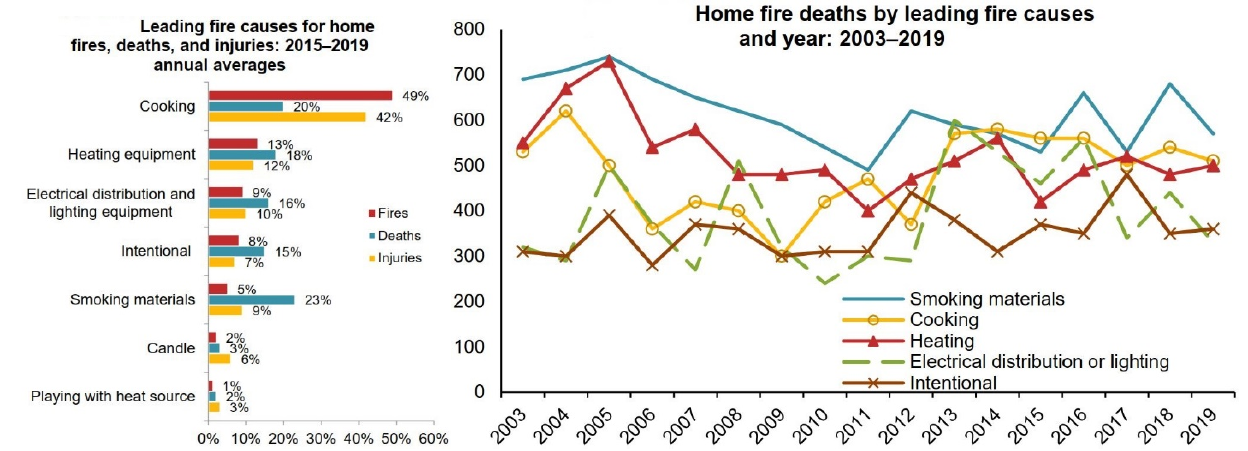
Figure 1. Leading causes of home fires and fire-related deaths and injuries according to 2021 NFPA report [13].